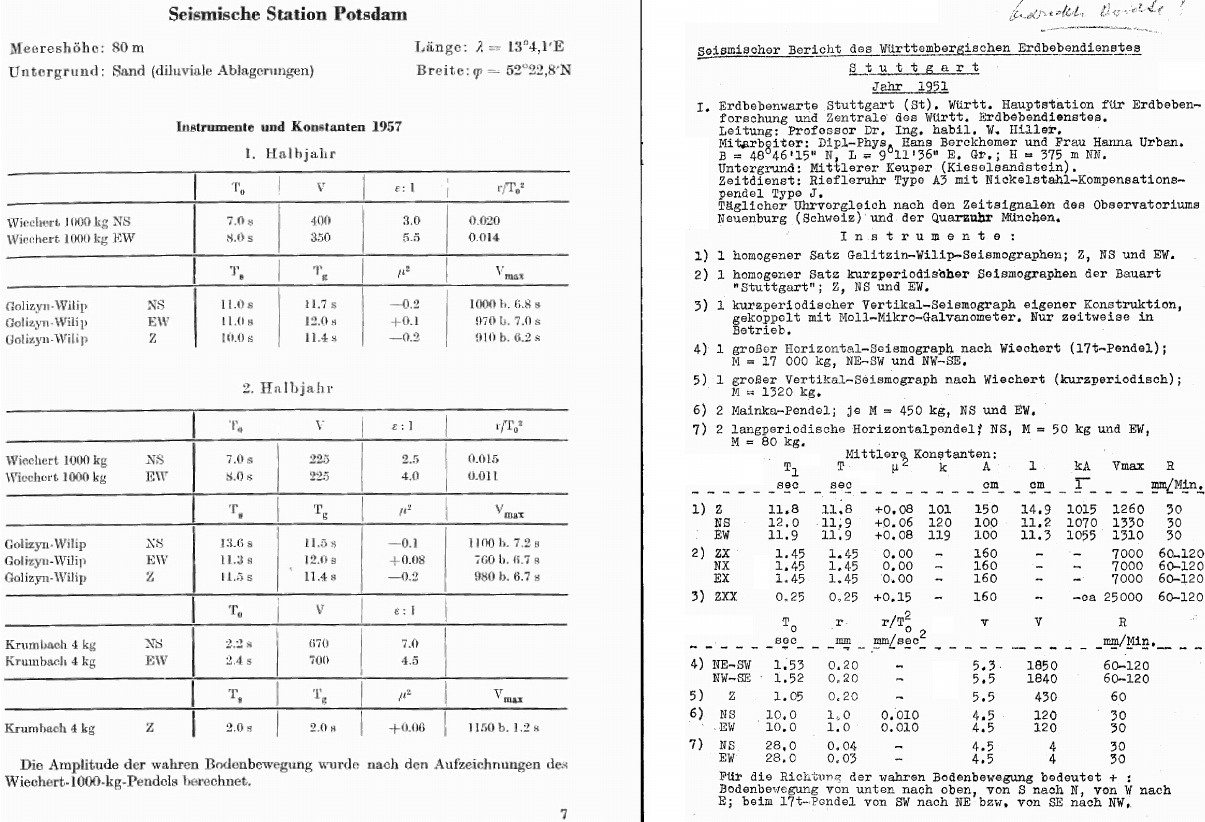
Figure 5. (a) Extract of the bulletin of the stations Potsdam (POT), Halle, Plauen and Sonneberg. In 1957, instrument parameters were changed twice at the station POT (Gerecke and Güth, 1961). (b) Extract from the bulletin “Seismischer Bericht des Württembergischen Erdbebendienstes” of 1951. At the station STU seven seismograph systems were installed recording on smoked and photo-optical paper (Hiller, 1951).